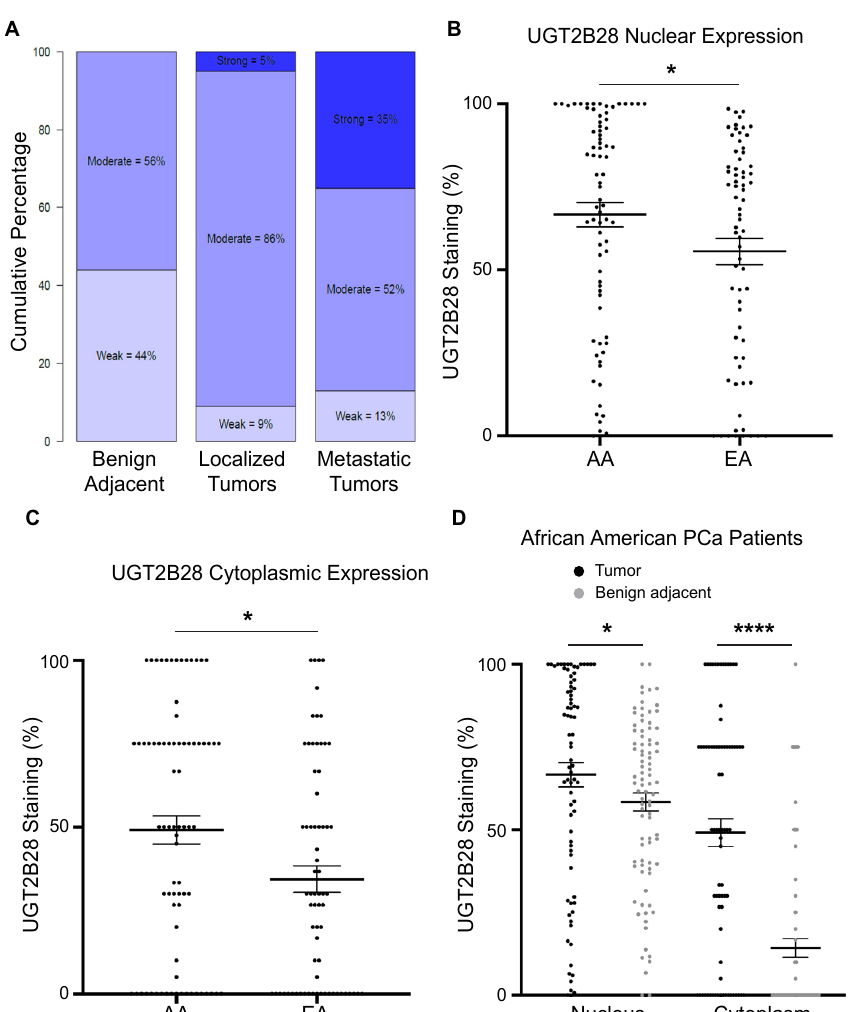
Figure 1. Increased UGT2B28 protein expression during prostate cancer progression and in African American prostate cancer patients. ( A ). Percentage of overall staining of UGT2B28 in benign adjacent tissue, localized tumors, and metastatic tumors. ( B ). Percentage of staining of nuclear UGT2B28 in African American vs. European American prostate tumors. * p < 0.05. ( C ). Percent staining of cytoplasmic UGT2B28 in African American vs. European American prostate tumors. * p < 0.05. ( D ). Percentage of staining of nuclear and cytoplasmic UGT2B28 in African American benign adjacent prostate tissue and prostate tumors. * p < 0.05, **** p < 0.0001. The data are represented as the mean +/ − the standard error of the mean